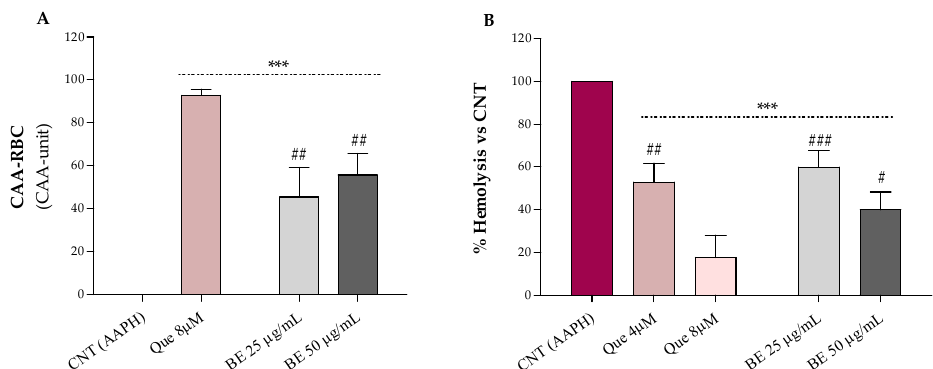
Figure 2. Effect of the bee pollen extract (BE 25 and 50 µ g/mL) on the cellular antioxidant activity– CAA ( A ) and AAPH-induced oxidative hemolysis ( B ) on oxidized human erythrocytes. Quercetin (Que) was used as a standard. Results were expressed as mean ± SD. One-way ANOVA with Bonferroni’s Multiple Comparison test: * significantly different from control (CNT, CAA = 0), *** p < 0.001; # significantly different from Que 8 µ M (corresponding to 2.4 µ g/mL): # p < 0.05, ## p < 0.01, ### p < 0.001.